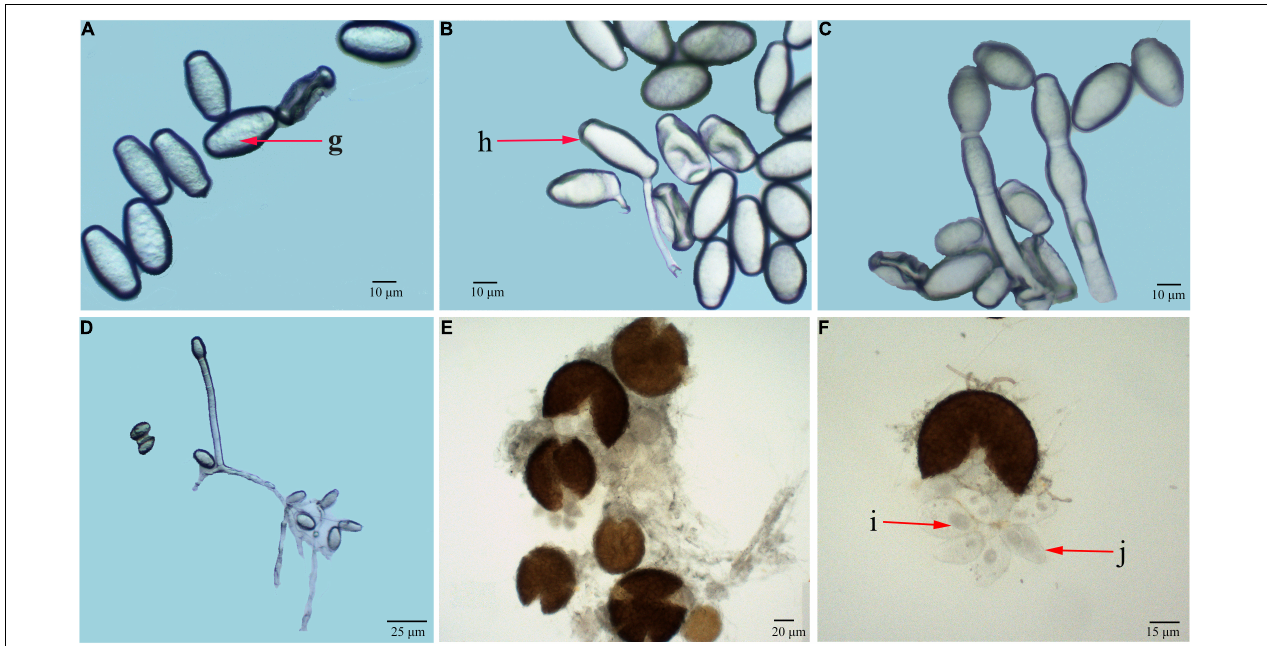
FIGURE 2 | Light microscopic observation of G. artemisiae on A. selengensis . Conidia (A,B) , conidiophore (C,D) , and chasmothecia (E,F) are shown. Conidia with no fibrosin body (g), conidial germination (h), ascus (i), and ascospores (j) are indicated by the red arrow.